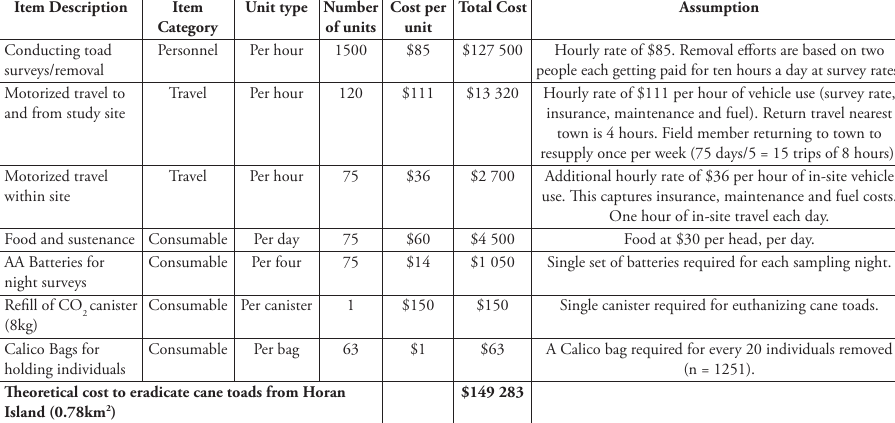
Table 1. Example areal metric costing and assumptions associated with a cane toad eradication program on Horan Island. Derived from incurred field costs and estimated mean removal estimates (75 days). All figures are in Australian Dollars